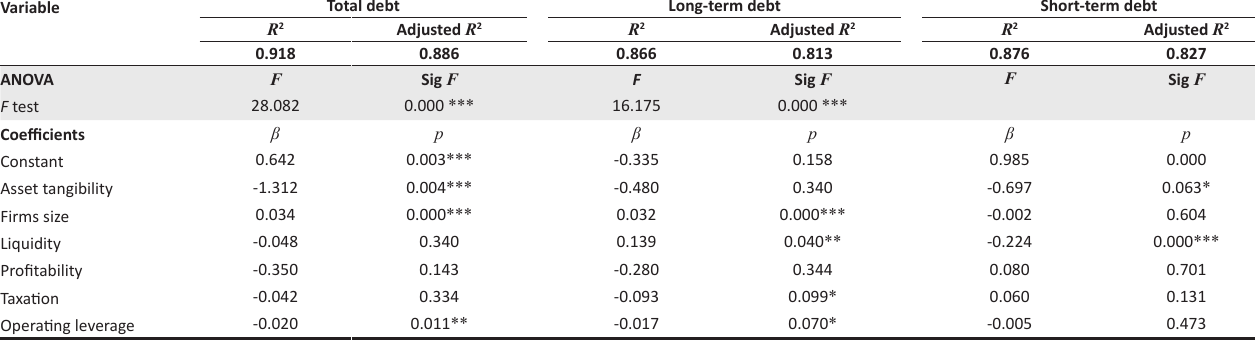
TABLE 10: Regression coefficients: Industrials sector